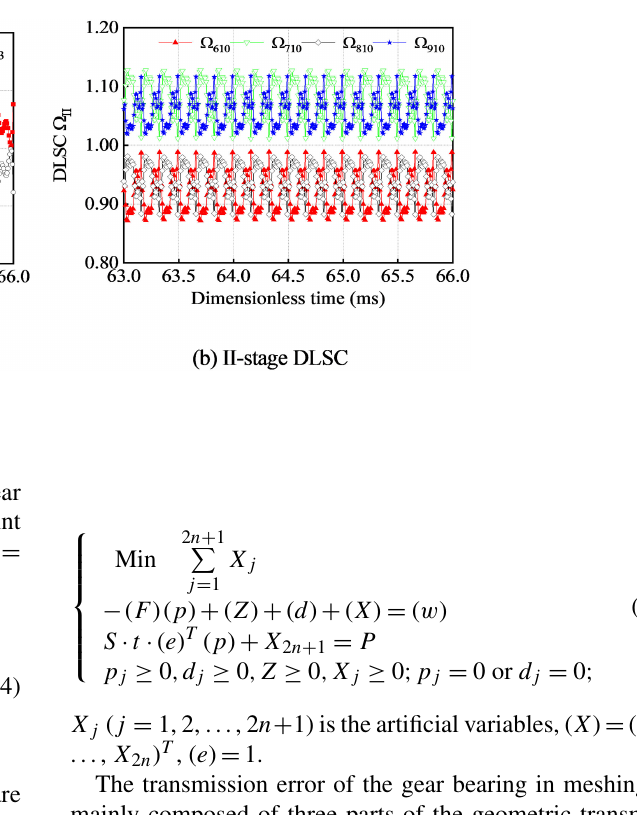
Figure 8. Time-varying meshing stiffness curve of each gear pair.